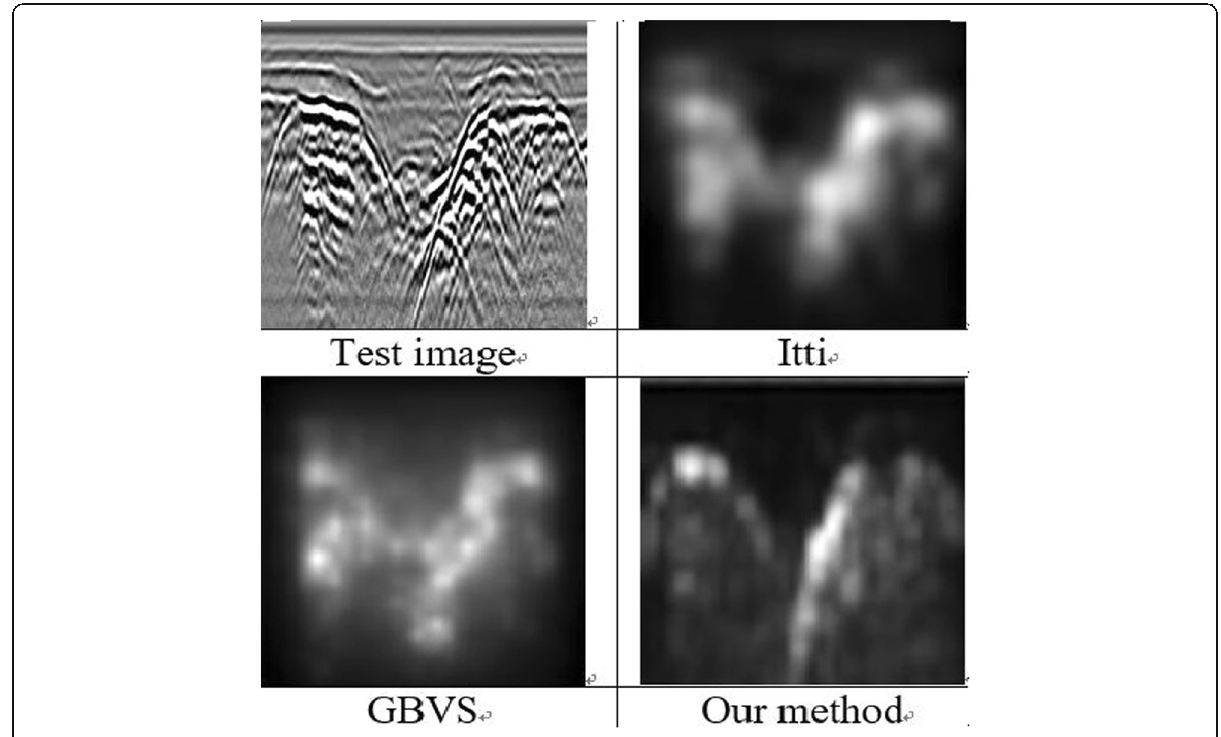
Fig. 4 Test image and saliency maps obtained by different saliency methods